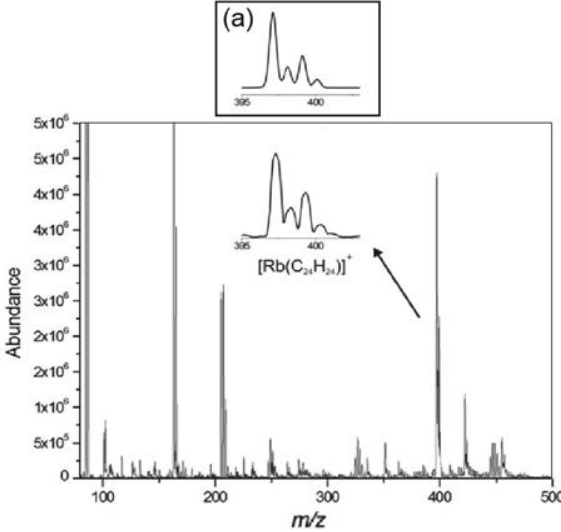
Figure 2 . Positive-ion mode ESI mass spectrum of a mixture of [2.2.2]paracyclophane (8 × 10 5 mol/L) with RbCl (2 × 10 –3 mol/L) in methanol/chloroform (1:1). The inset shows the real isotope pat- tern of the [Rb(C 24 H 24 )] + complex on an expanded mass scale. The inset (a) provides the calculated isotope pattern of the considered [Rb(C 24 H 24 )] +